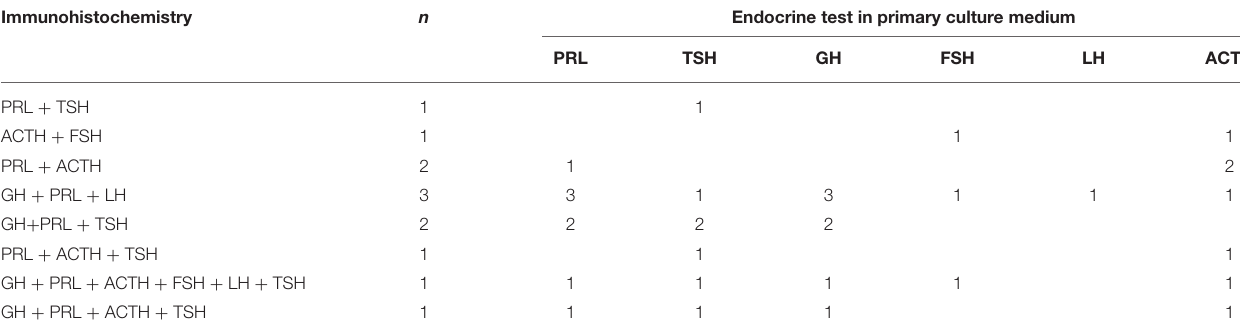
TABLE 4 | Comparison of endocrine test in primary culture medium and immunohistochemical test of tumor tissue.